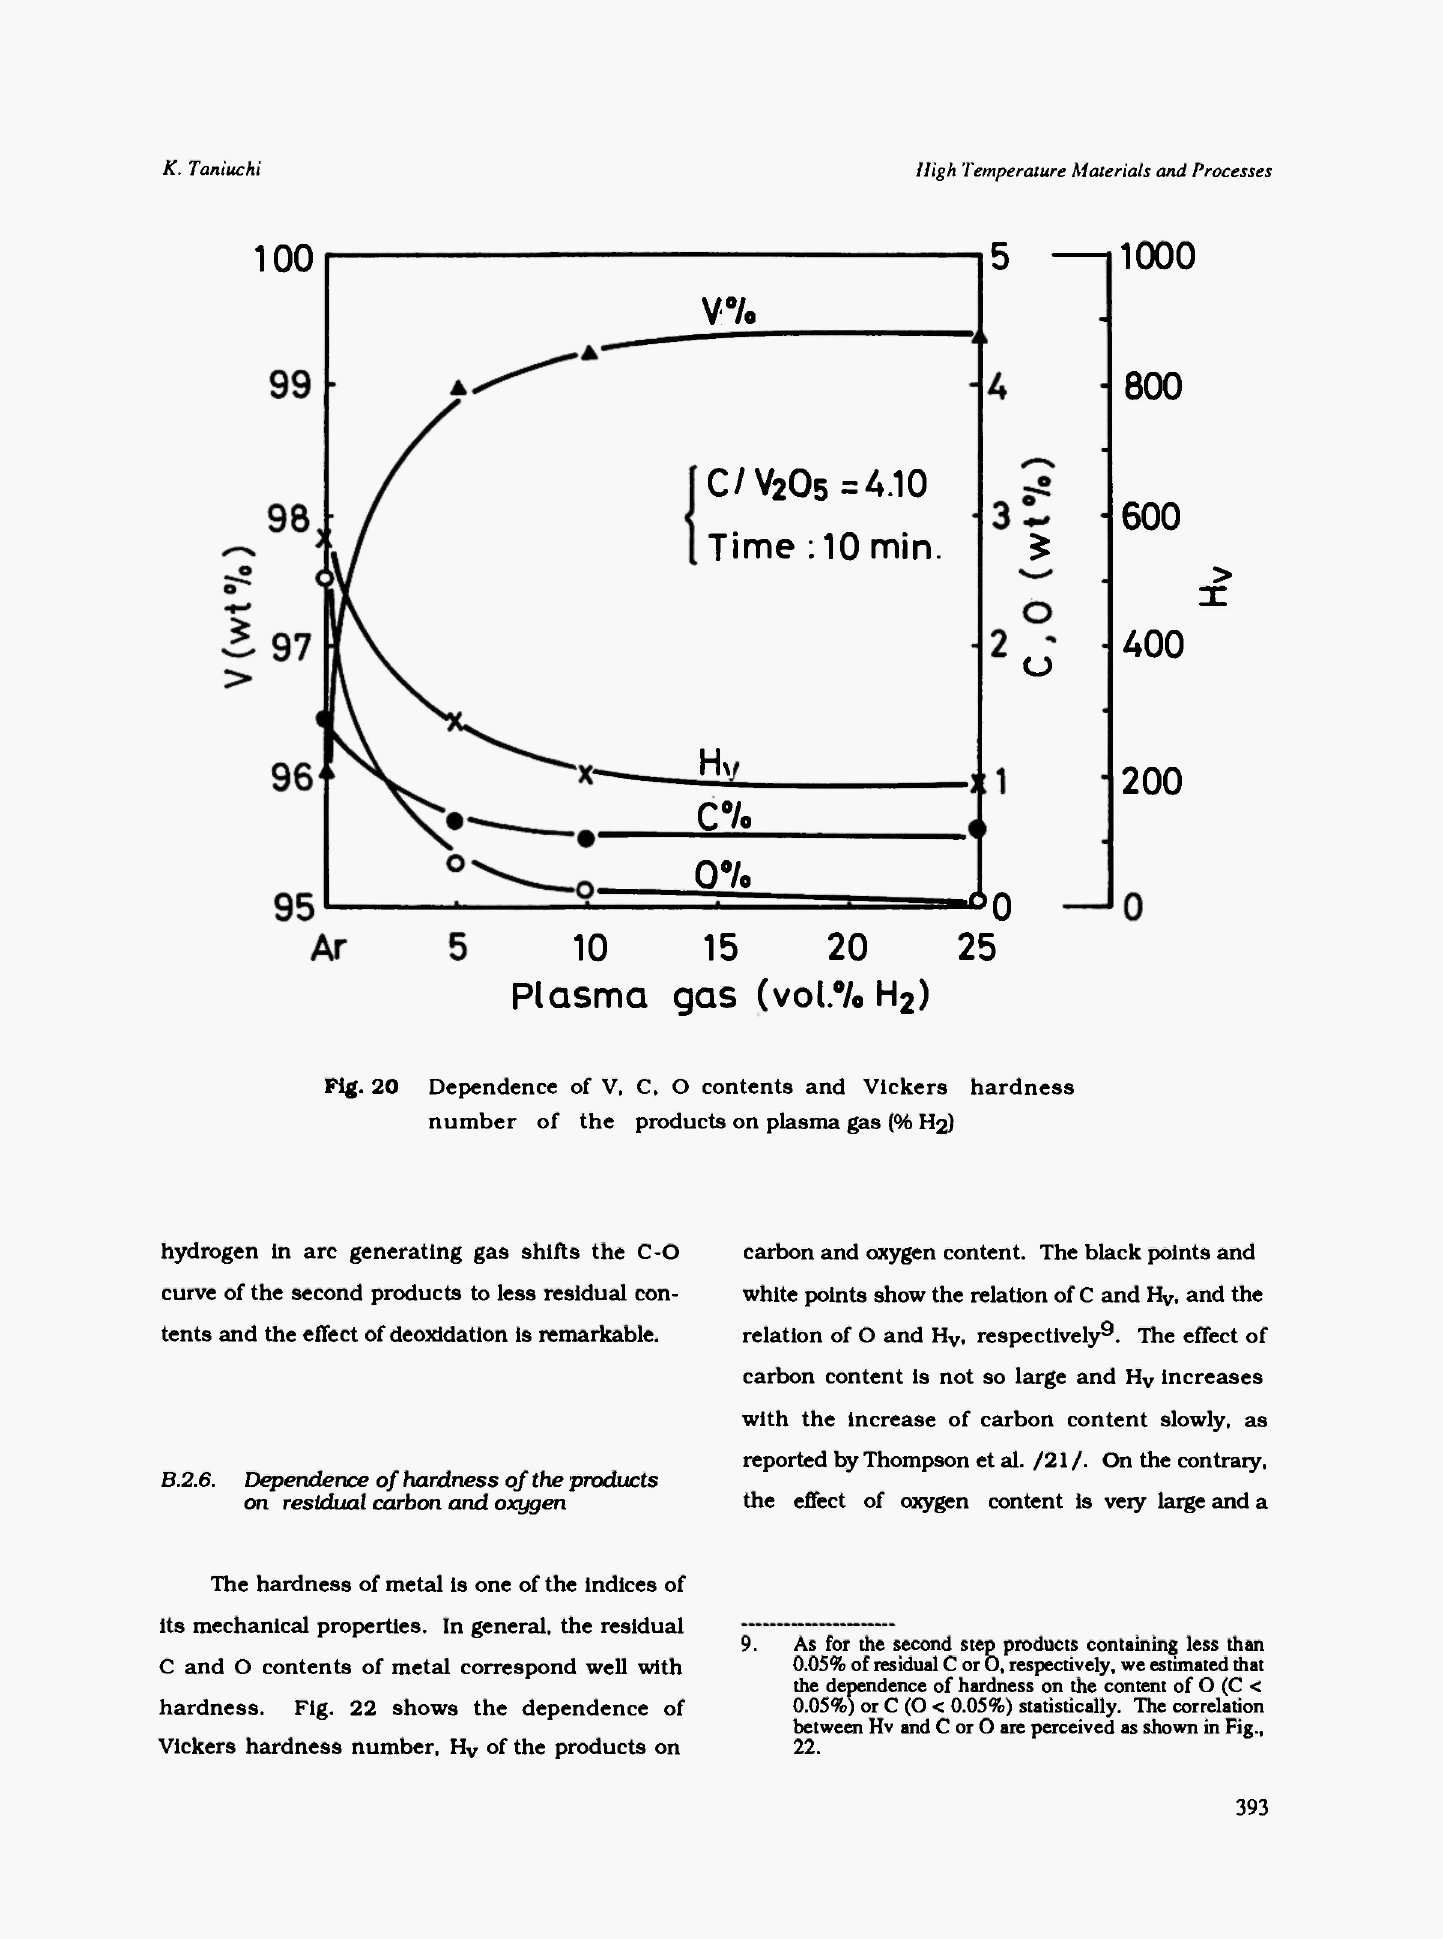
Fig. 20 Dependence of V, C, Ο contents and Vickers hardness number of the products on plasma gas (%